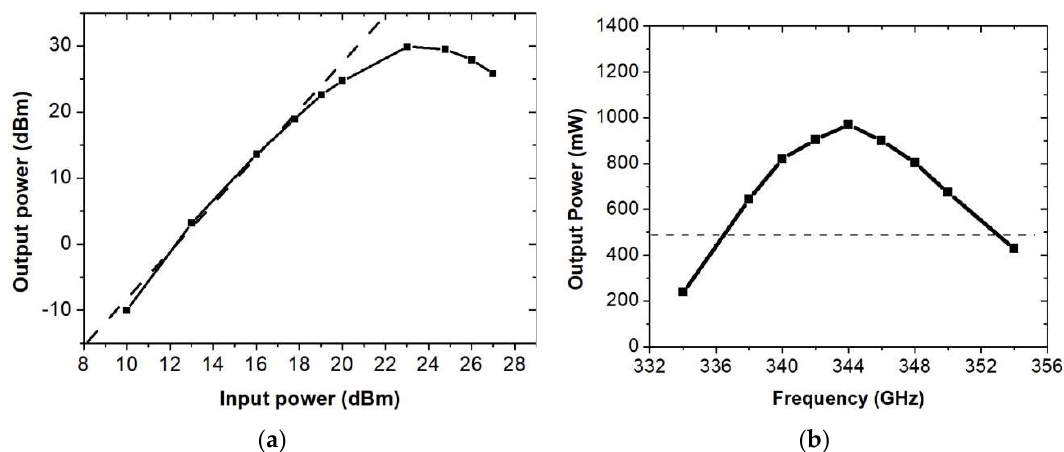
Figure 24. gain property ( a ) and bandwidth property ( b ) of PA-HHTWT. Figure 24. Gain property ( a ) and bandwidth property ( b ) of